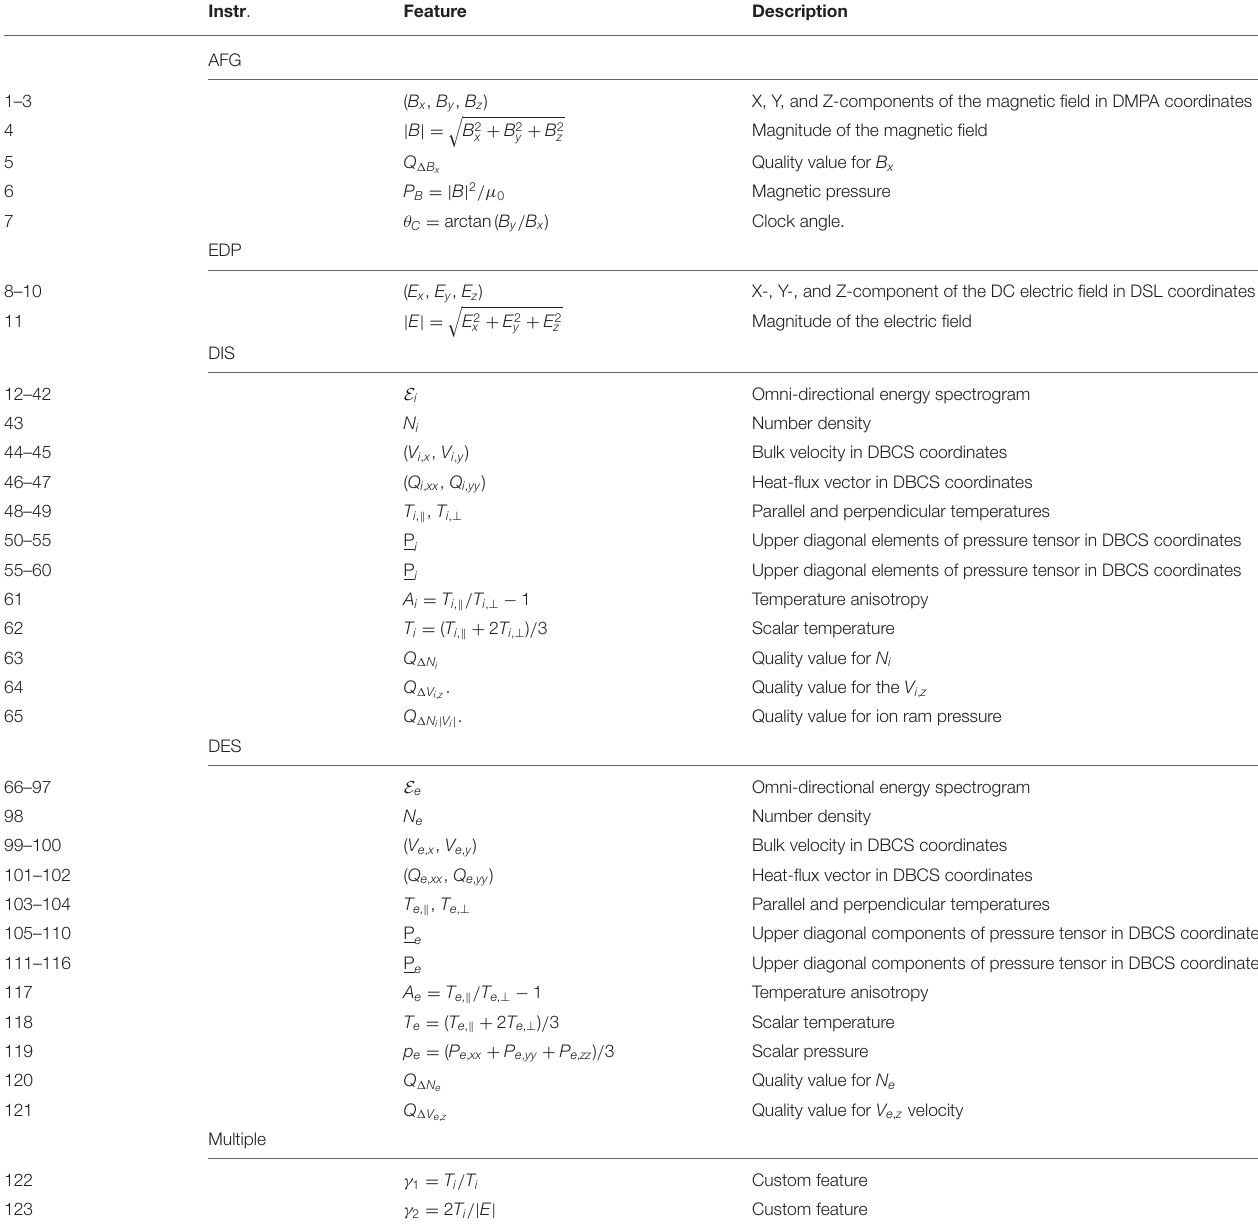
TABLE 2 | Features used for the development and application of the GLS magnetopause model. Instr